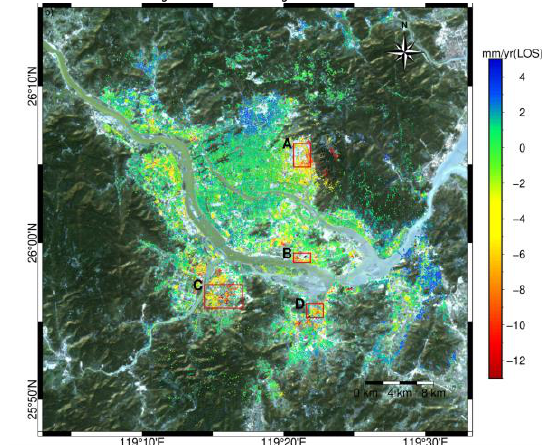
Figure 3 . Land subsidence rate in the line of sight (LOS) direction of Fuzhou from May 2017 to May 2021. And the areas in the four red boxes are areas with relatively serious